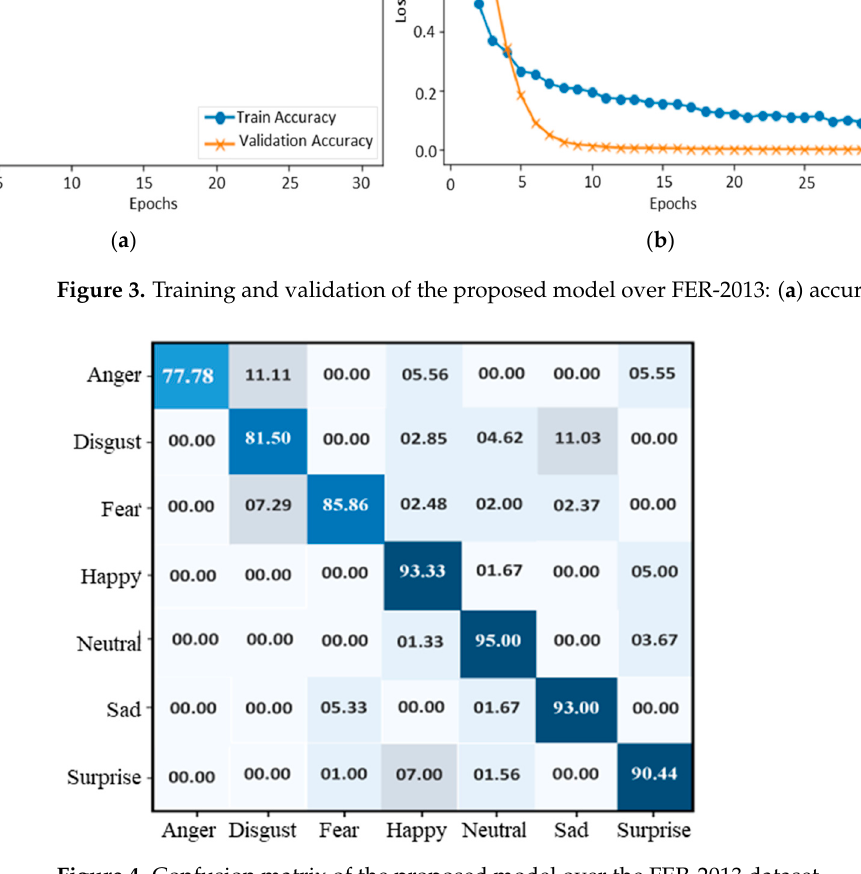
Table 3. Cross-validation over the KDEF dataset.